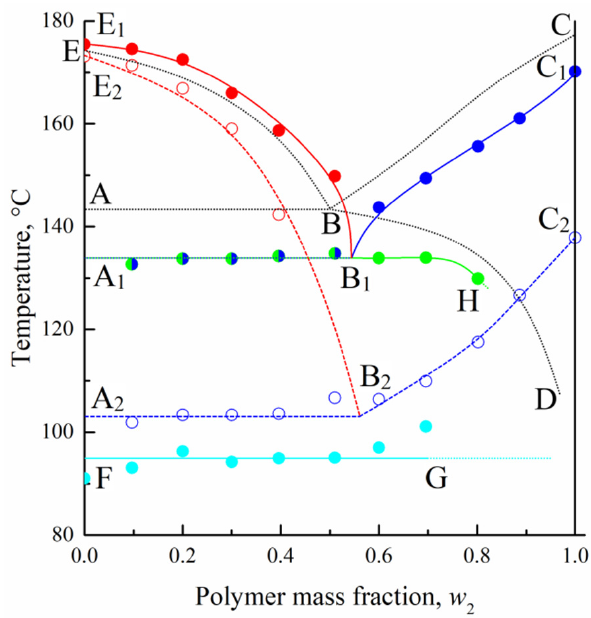
Figure 6. Dynamic phase diagram for the PVDF–camphor system. Solid and open points correspond to DSC 2nd heating and cooling data, respectively. Black dotted curves are replotted from the phase diagram constructed by the quasi-equilibrium optical method (Figure 2). See the text for explana- tions.